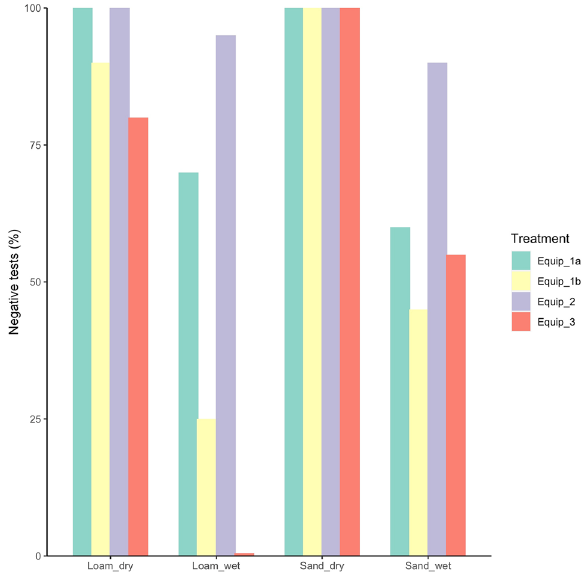
Figure 12. Success rate (% of negative tests, n = 20) of the equipment tested for each of the soil/moisture regimes. Equip_1 = handheld brush + disinfectant (a = 70% methylated spirits, b = 2% BAC); Equip_2 = fixed boot brush and 10% BAC footbath; Equip_3 = hygiene station with fixed boot brush and 10% BAC spray. The zero value was changed to 0.5 to aid with the visual display of data.